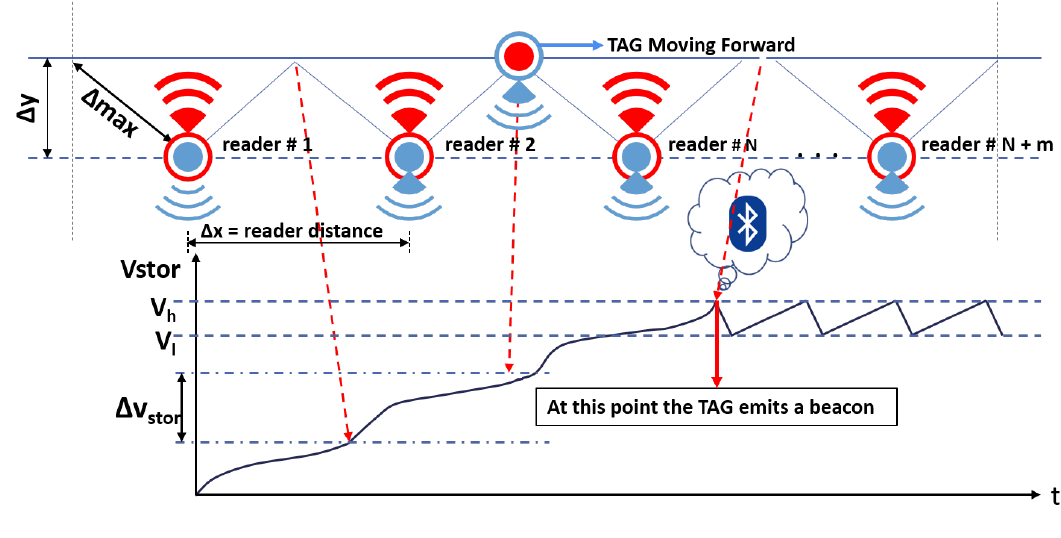
Figure 4. Wireless power transfer and V stor